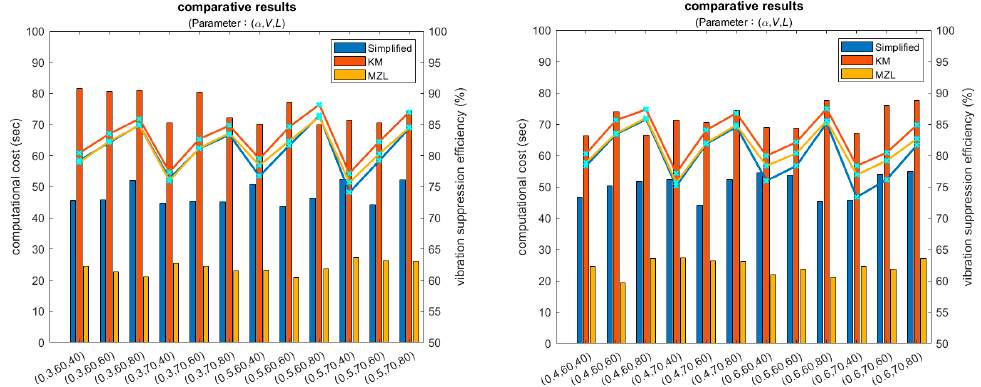
Figure 13. Bar-line chart showing the comparative results (bar—CC, line—VSE). Table 6. Test of performance